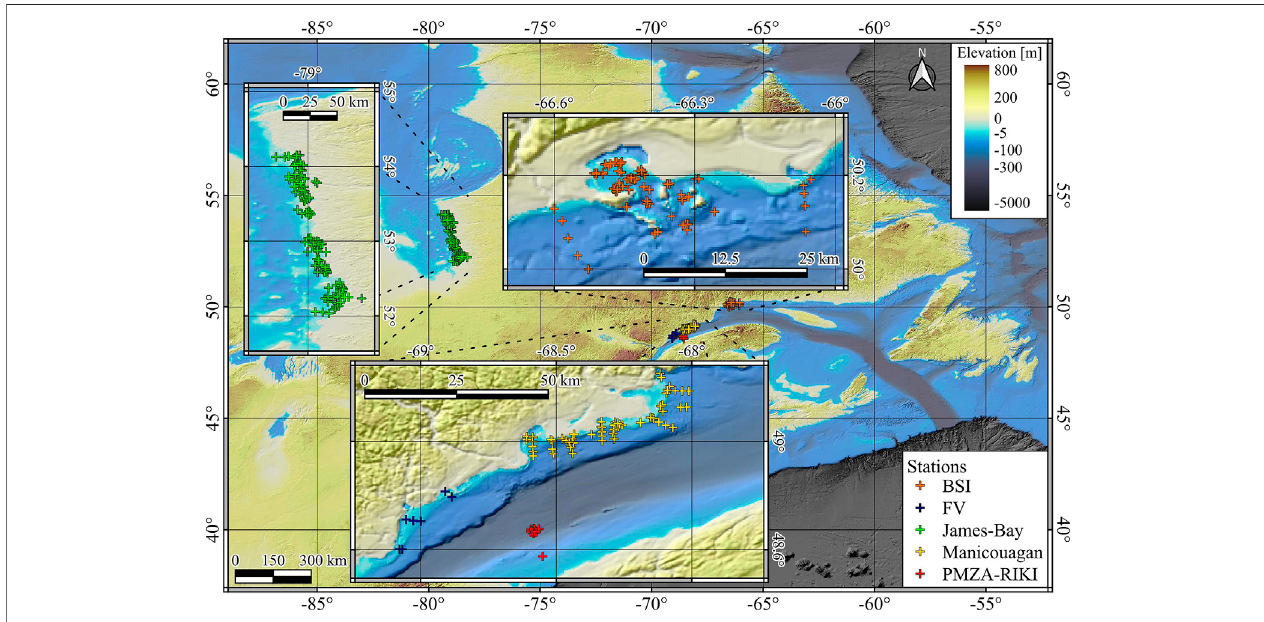
FIGURE 1 | Localization map of the datasets, colors correspond to the different areas in which the data were acquired.